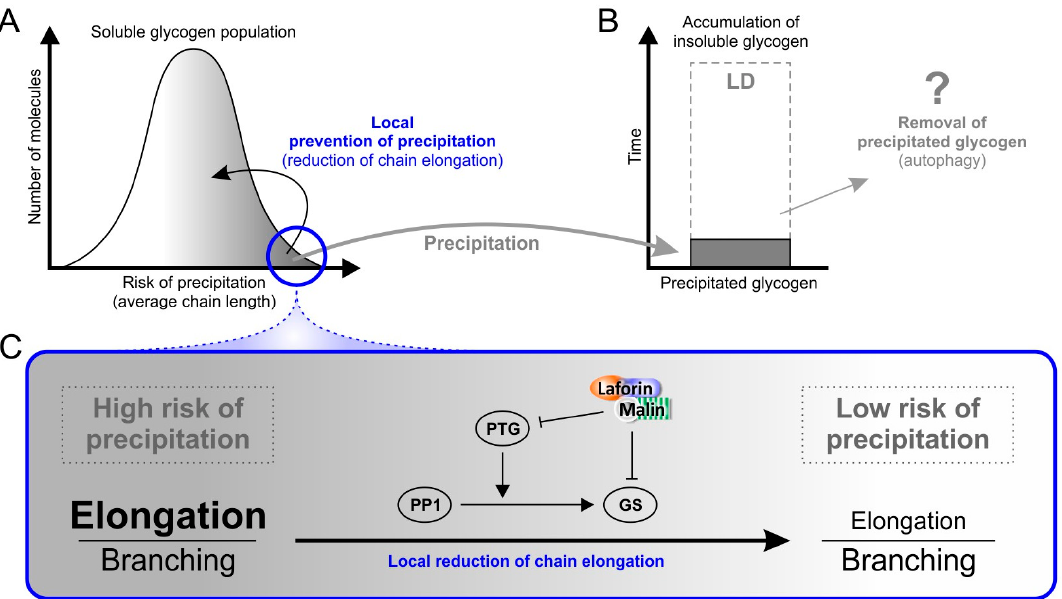
Figure 5. Mechanistic model for Lafora body formation and accumulation. ( A ) Glycogen as a disperse mixture of molecules that possess different contents of long glucan chains and according risks of precipitation. The minor proportion of molecules (blue circle) actually subject to precipitation (grey arrow) may be modified by local reduction of chain elongation that is achieved by a well-supported mechanism explained in ( C ). This modification increases the relative branching frequency and decreases the risk to precipitate; ( B ) If glycogen precipitation is not (entirely) avoided, precipitated glycogen is accumulating over time ( y -axis) as seen in Lafora disease, unless cells are able to mobilize and remove precipitated glycogen (e.g., hypothetically (question mark) through autophagy) at a rate that is higher than that of precipitation; ( C ) The mechanism by which a functional laforin-malin complex can reduce GS activity as supported by experimental data obtained in cell-culture [30,58]. Negative effects are indicated by inhibitory arrows while normal arrows indicate a positive effect. By targeting GS and PTG to degradation, the laforin-malin complex reduces GS activity and relatively increases branching frequency. It is proposed that this process may not significantly affect the entire GS population but is occurring locally, i.e., predominantly at a minor proportion of glycogen molecules with a high risk of precipitation (blue circle in ( A )).